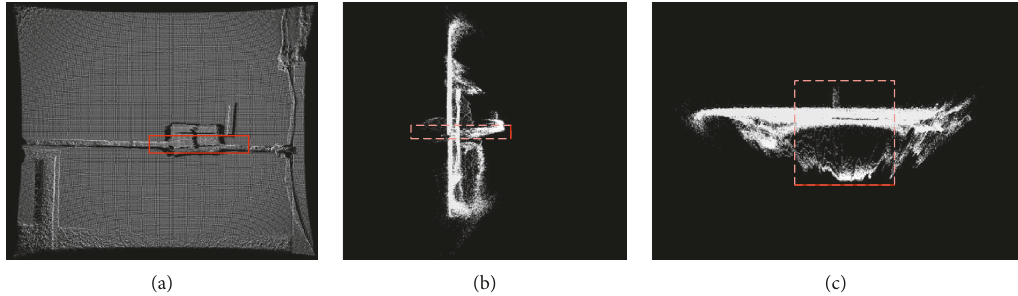
Figure 10: ROI (highlighted in red) for vibration measurement in the cantilever steel beam experimental case 2. 3D point cloud: (a) front view, (b) left view, and (c) top view.